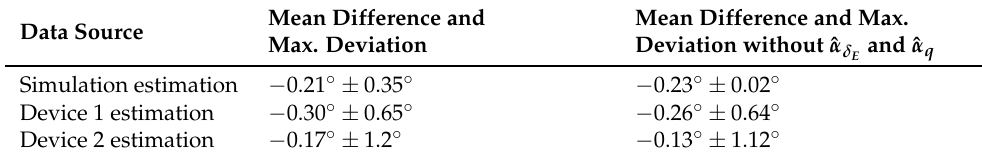
Table 3. Mean difference and maximal deviation between the AoA in the test flight (“Device 1” and “Device 2”) and the flight simulator “Sim.est.”, all in reference to